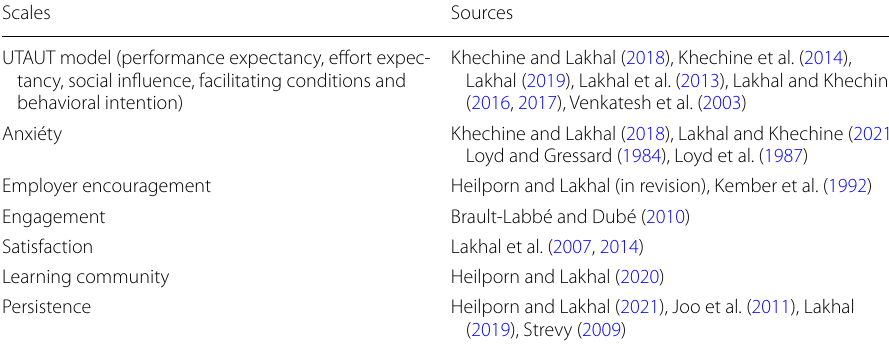
Table 3 Sources of the scales used in the study Scales